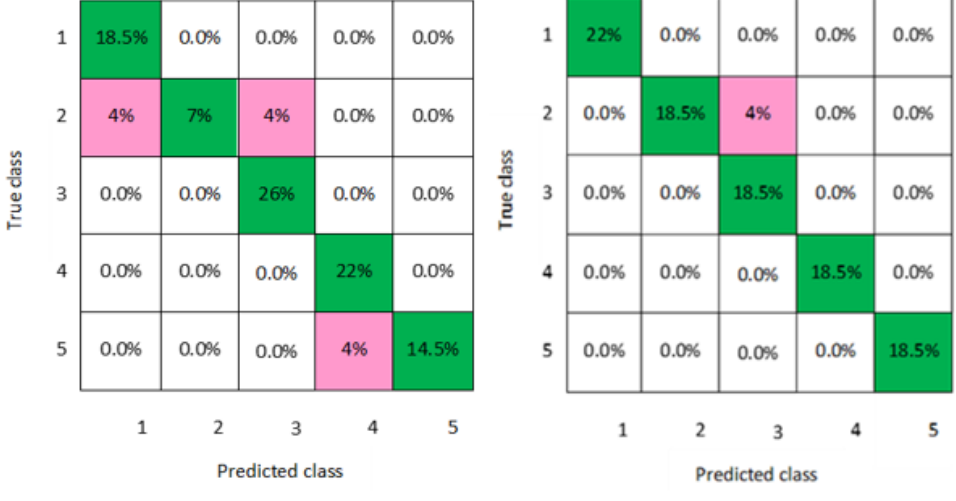
Figure 8. Weighted KNN confusion matrixes for men and women data, respectively.